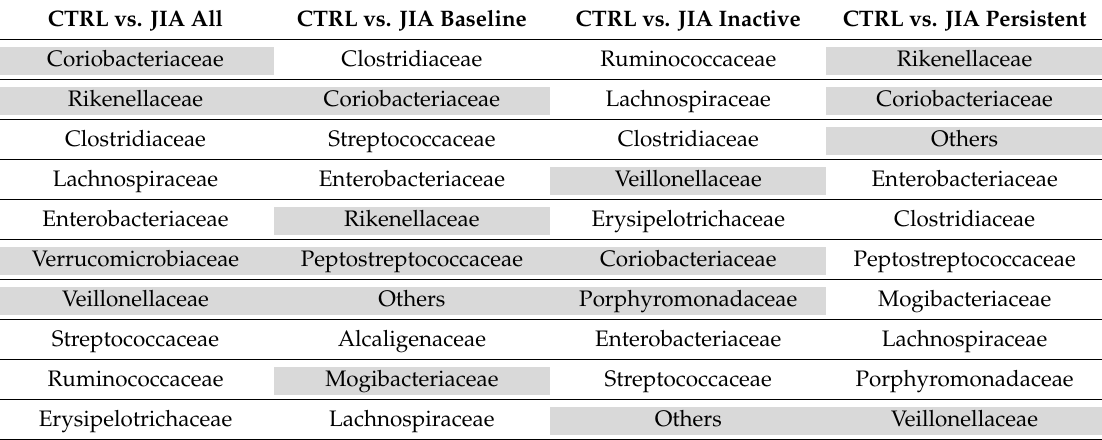
Table 5. Microbial features derived from PLS-DA models in DCV of OTUs at family level. CTRL vs. JIA